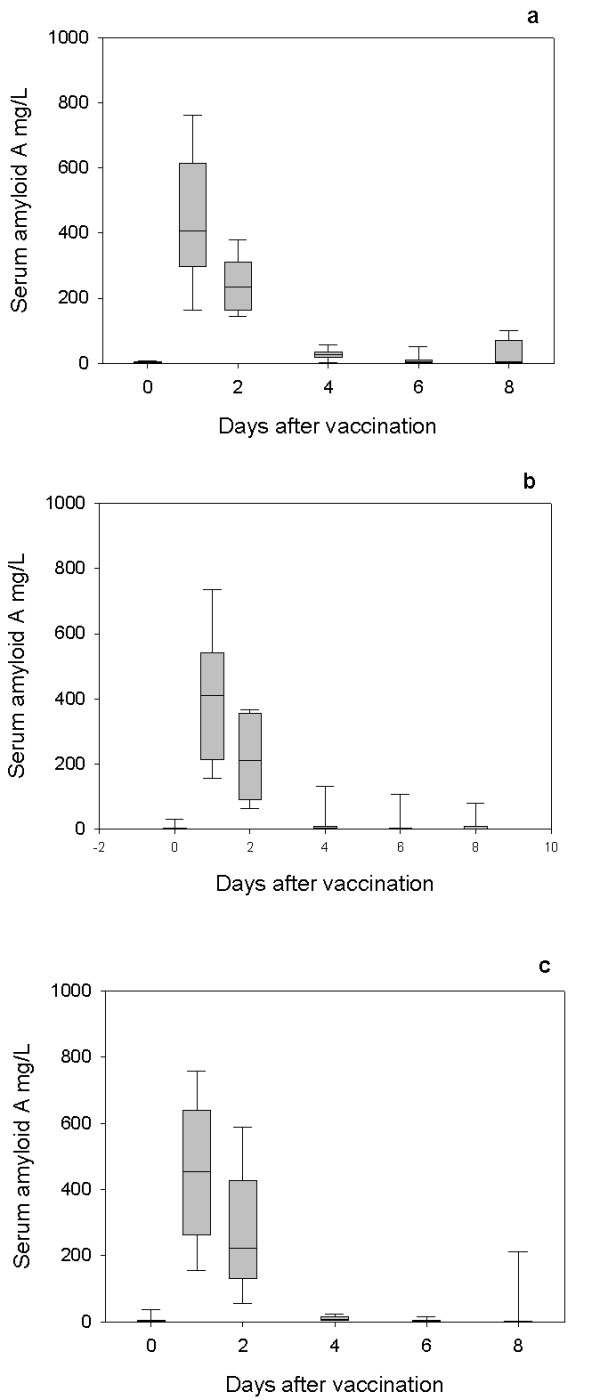
SAA response to primary vaccination with Heptavac. The concentrations of serum amyloid A in lambs (n = 10) following the first vaccination with Heptavac. The maternal diets of the lambs were High/High (a), High/Low (b) and Low/High (c). The plots show the median as the line in the box, the 25th and 75th percentile are represented by the box with the whiskers representing the 10th and 90th percentiles.